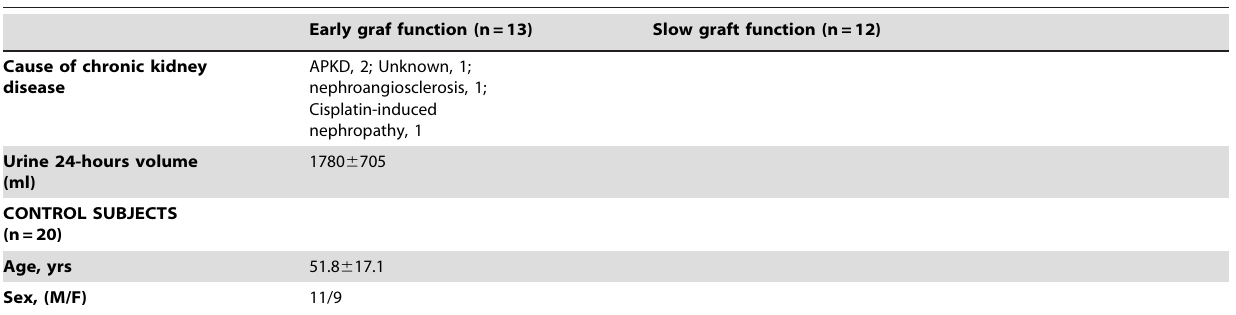
Early graf function (n=13) Slow graft function (n=12) APKD, 2; Unknown, 1; nephroangiosclerosis, 1;